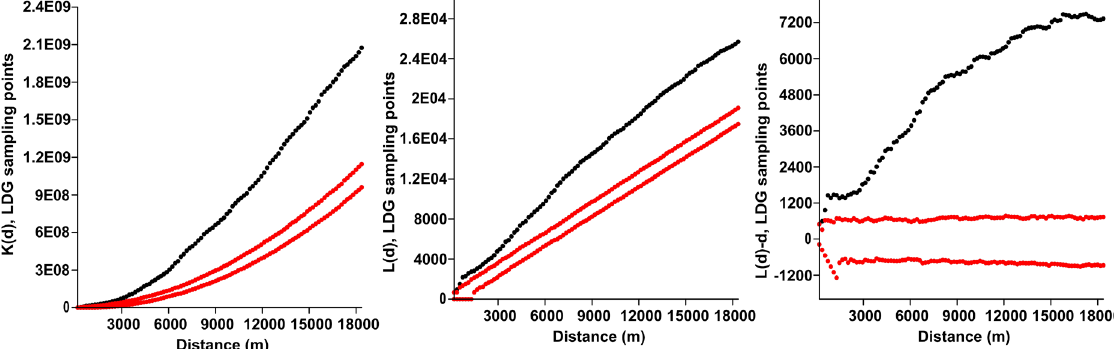
Figure 4. The function for the observed LDG distribution appears in black; the three graphics correspond to functions K( d ), L( d ), and L( d )- d , which are above the 95% confidence interval (red functions), indicating a tendency towards a clustered